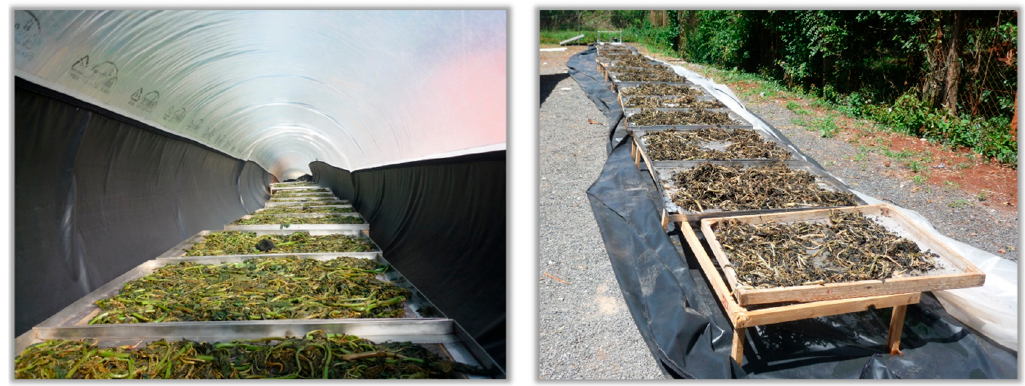
Figure 2. Placement of trays on wooden frames inside the ISD.